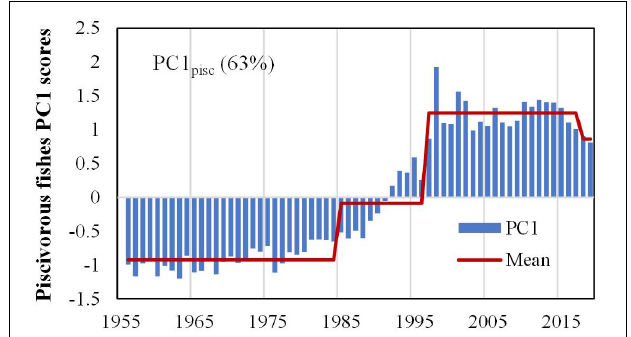
FIGURE 4 | Principal component analysis (PCA) of the catch of the seven piscivorous taxa shows regime shifts in PC1 (explaining 64% of the variations).